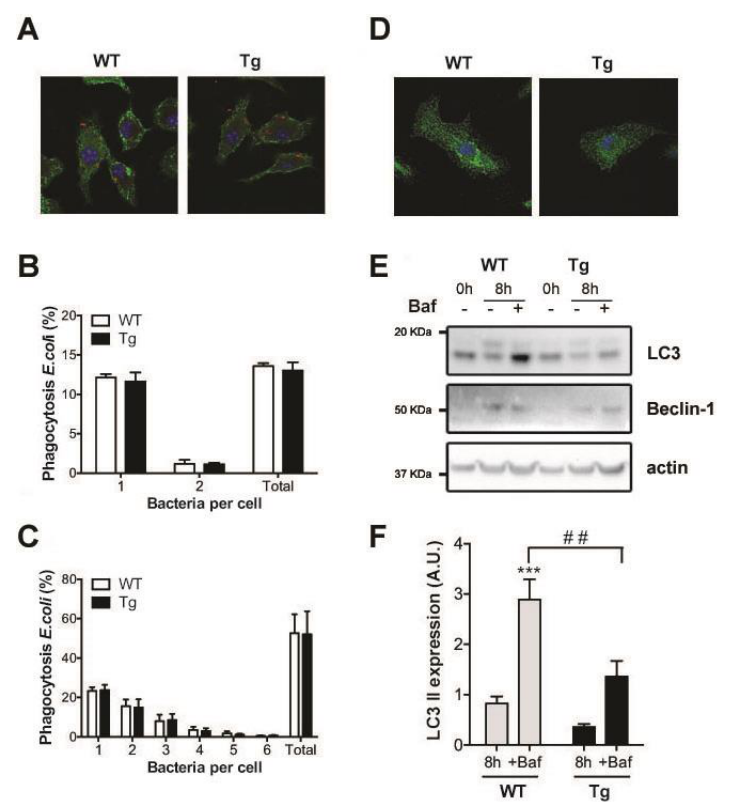
Figure 4. Phagocytosis and autophagy analysis in BMDM from hORMDL3 Rosa26 mice. ( A – C ) Intracellular phagocytic uptake of E. coli after 30 min of incubation in BMDM from WT and Tg mice. ( A ) Immunofluorescence staining of fluorescently labeled E. coli (red) at a 5:1 ratio; Concanavalin A staining (green) marks the plasma membrane and Topro counterstain (blue) indicates the location of nuclei. Pictures were taken using a SP8 confocal microscope with a 63× objective. ( B , C ) Quantification of intracellular E. coli per cell at a ratio of ( B) 5:1 and C, 20:1 displayed in % with respect to the total number of cells ( n = 3). ( D – F ) Autophagic markers after 100 ng/mL LPS treatment in BMDM from WT and hORMDL3 Rosa26 (Tg) mice. ( D ) Immunofluorescence staining of LC3 (green) and TO-PRO-3 ( blue ) after 8 h of LPS treatment ( E ) Representative Western blot of LC3 and Beclin-1 after 8 h of LPS treatment without and with Bafilomycin A ( Baf ). ( F ) Quantification of their expression after 8 h of LPS treatment. Data have been corrected by β -Actin and normalized to values at time 0 h in each group ( n = 6; t -test analysis of WT compared to untreated WT *** p < 0.001; t -test analysis of Tg compared to WT ## p < 0.01). Error bars represent standard error.